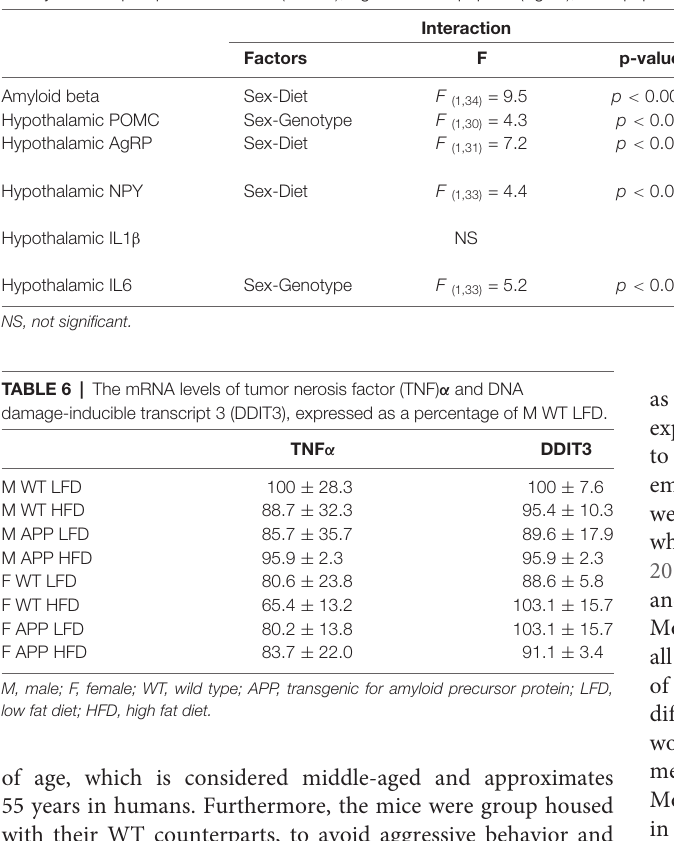
TABLE 5 | Significant results of the three-way ANOVA, showing the value of F (degrees of freedom between groups, degrees of freedom within groups) and the p -value of amyloid beta proopiomelanocortin (POMC), Agouti related peptide (AgRP), neuropeptide Y (NPY), and interleukin (IL)1 β in the hypothalamus. Interaction